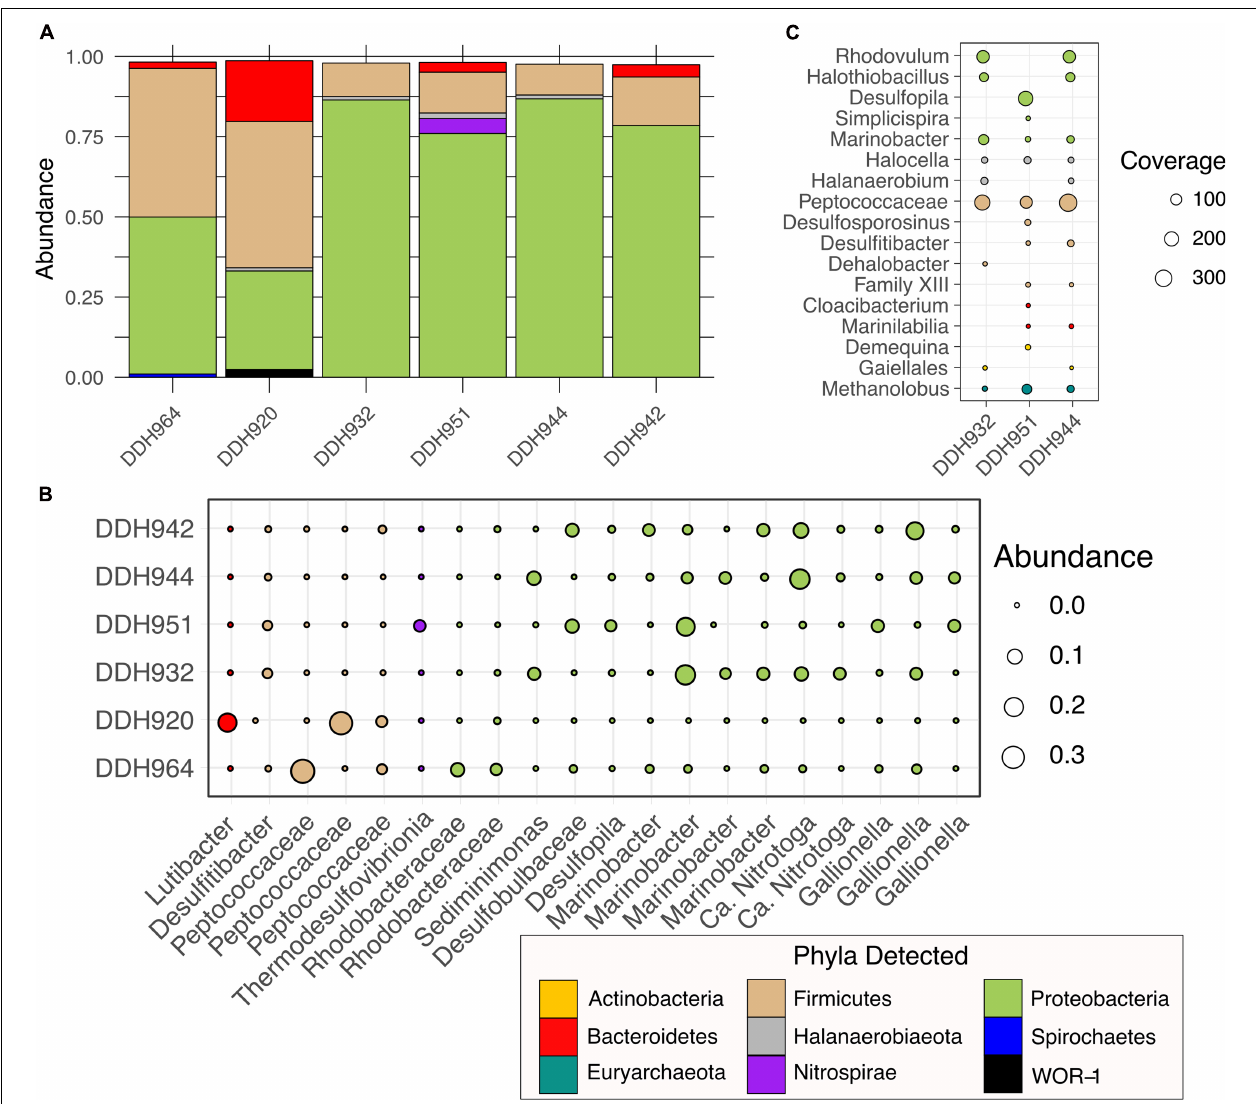
FIGURE 2 | Phylum and OTU 0 . 03 level diversity in borehole microbial communities. (A) Abundance of phyla recovered from pyroTag sequencing, (B) Individual OTU 0 . 03 abundance, and (C) Total coverage by phyla for 16S rRNA genes assembled from the shotgun metagenome raw